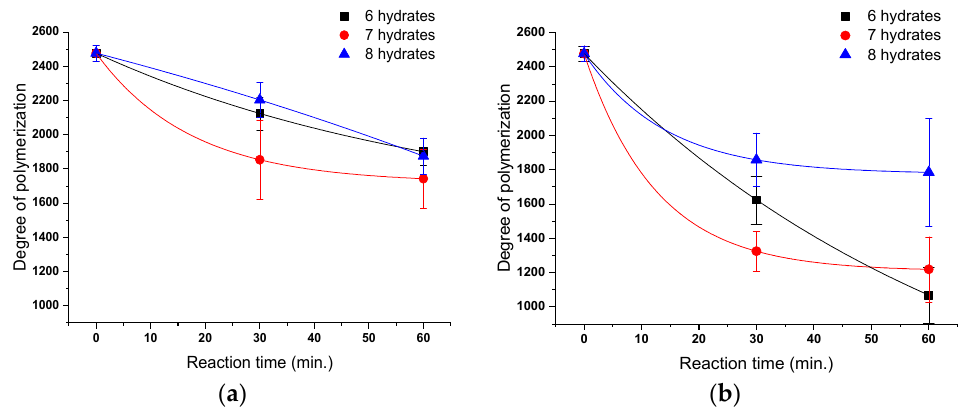
Figure 3. Changes in degree of polymerization (DP) of cellulose (Whatman No. 1 paper) as function of the number of hydrates in calcium thiocyanate (reaction temperature: ( a ) 100 °C, ( b ) 120 °C). To quantify these e ff ects, the kinetics of the cellulose hydrolysis rate according to each